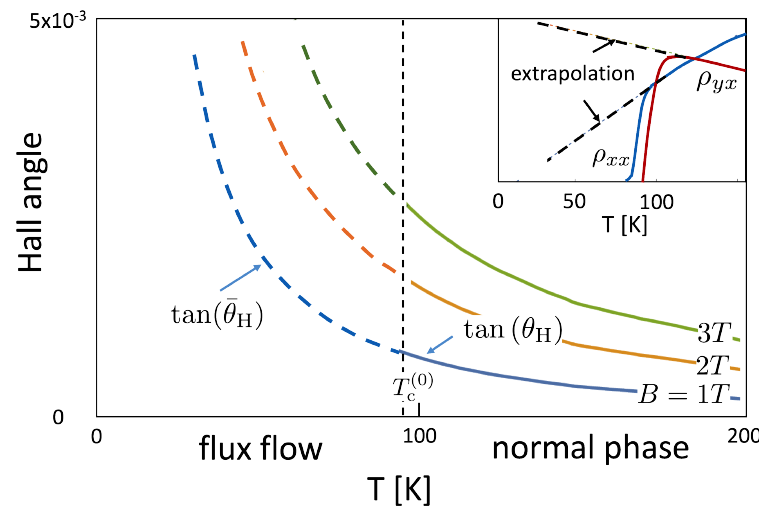
Figure 6: Extrapolation (dashed lines) of the Hall angle from the normal state of Bi Sr CaCu O into the FF regime using the ratio of linearly extrapolated resistiv- 2 2 2 8 − x ities (Inset) of the normal phase data of Ref. [ 6 ] .